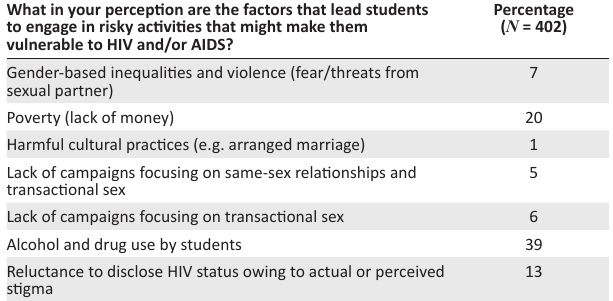
TABLE 2: Students’ perceived vulnerability to HIV and/or AIDS.